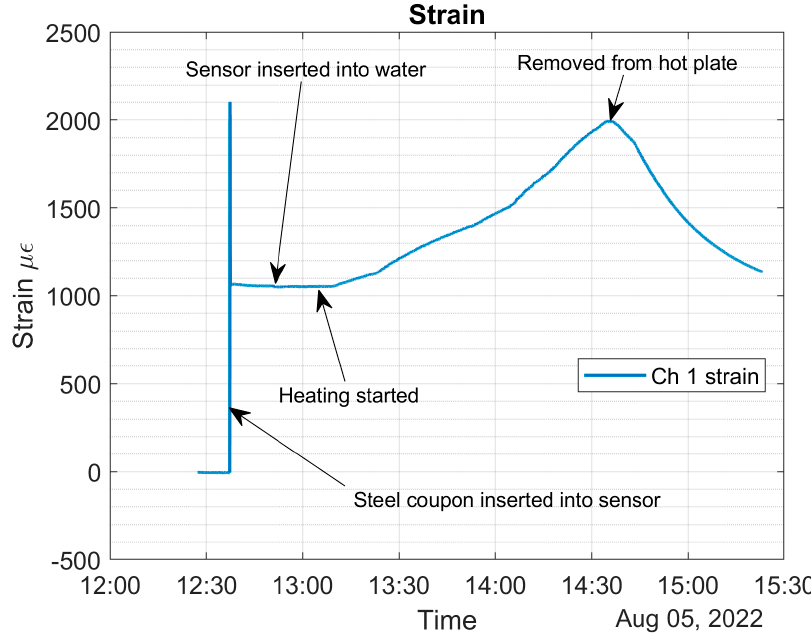
Figure 24. Corrosion sensor strain versus time in the heated water solution.